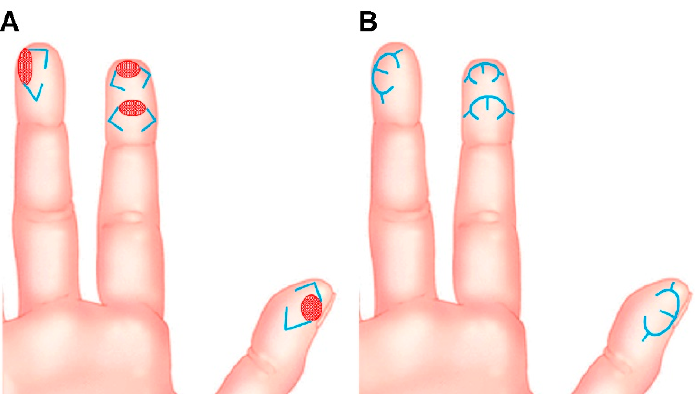
Figure 1. Schematic diagrams of modified mini-keystone flap (m-KF) reconstruction for tiny volar defects of the fingertip. ( A ) Various tiny volar defects of the fingertips (red-colored ovals) and designs of the modified m-KFs (blue-colored lines). ( B ) Final appearance after coverage of the modified m-KFs (blue-colored lines).